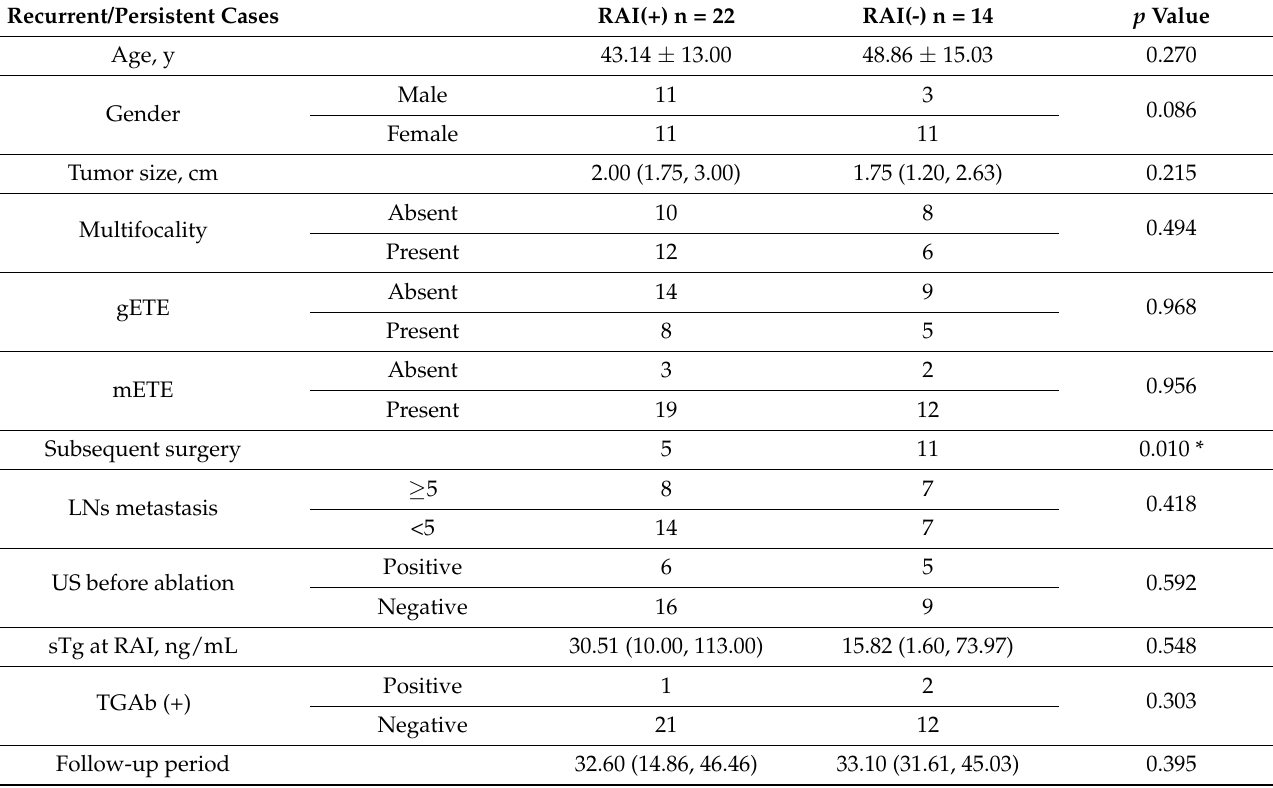
Table 2. Clinicopathologic characteristics of patients with structural recurrences (n = 36).